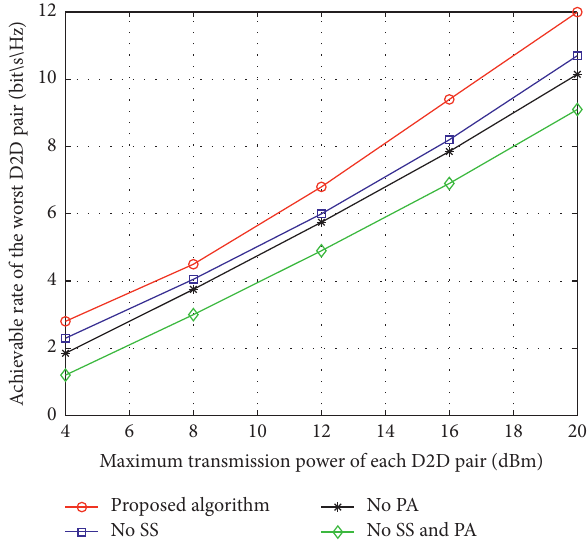
Figure 5: The achievable rate of the worst D2D pair for different maximum transmission power of each D2D pair.